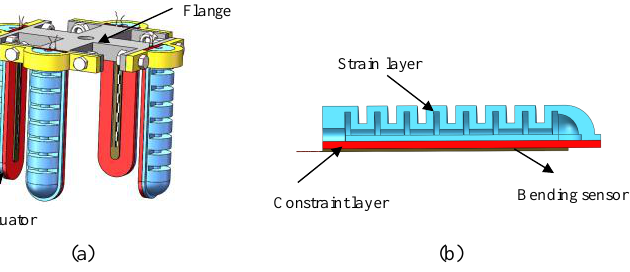
Figure 1. ( a ) Structure diagram of soft manipulator; ( b ) internal structure diagram of soft actuator.